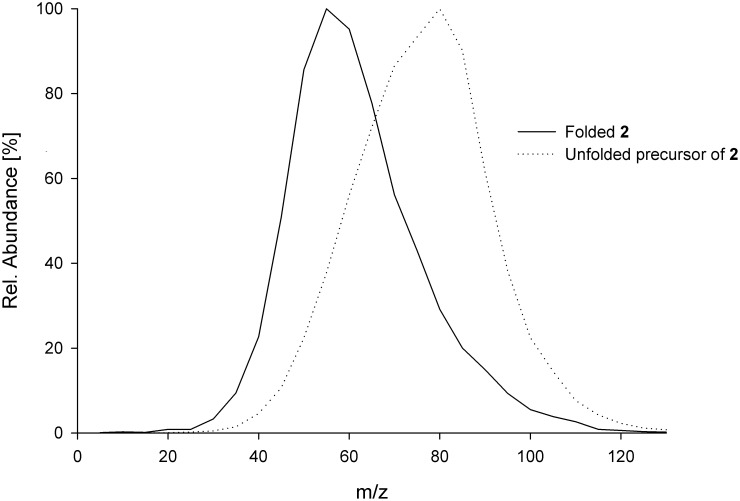
Optimization of the collision energy towards a maximum formation of fragment c10y26 of 2.